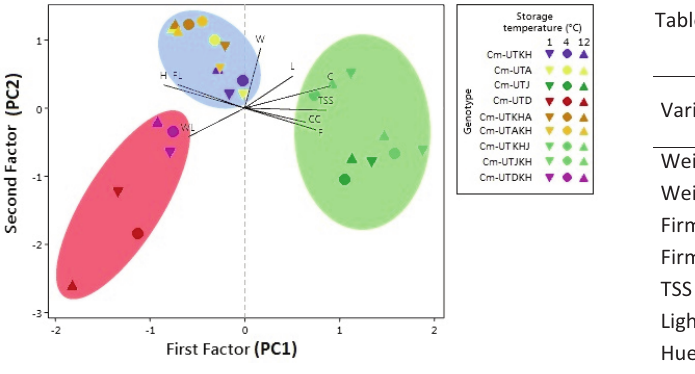
Fig. 3 ­ Principal component analysis for the studied melon. Loading factors represent the average performance of the studied types calculated as the mean for each loa­ ding variable of each type during storage period (the ave­ rage of 0, 10, 20, and 30 days in cold storage). W (Weight), WL (Weight loss), F (Firmness), FL (Firmness loss). TSS (Total soluble solids), L (Lightness), H (Hue), C (Chroma), CC (Color changes).